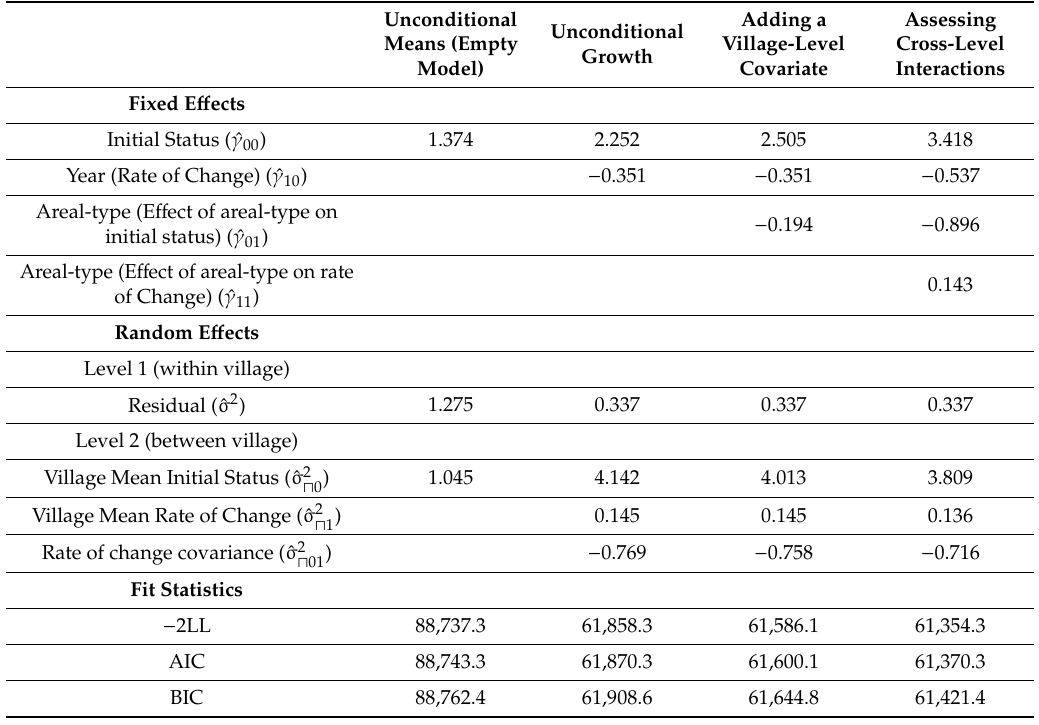
Table 3. Results of fitting multilevel-growth models to schistosomiasis RIR in 4379 villages in the 30 most endemic counties, Hubei Province, China.